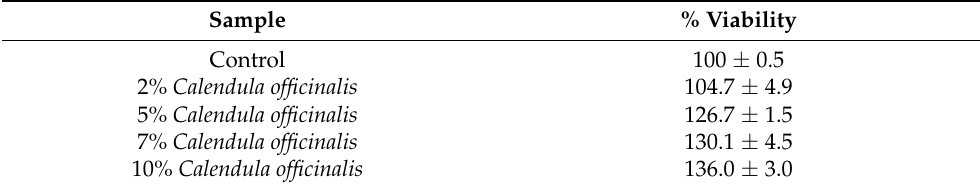
Table 1. Human gingival fibroblast cells’ viability by MTT assay.